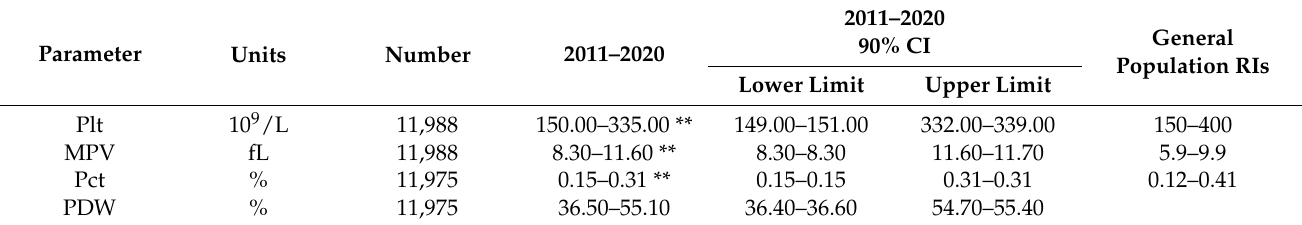
Table 6. Reference intervals (RIs) and basal values for platelet count and associated parameters (females and